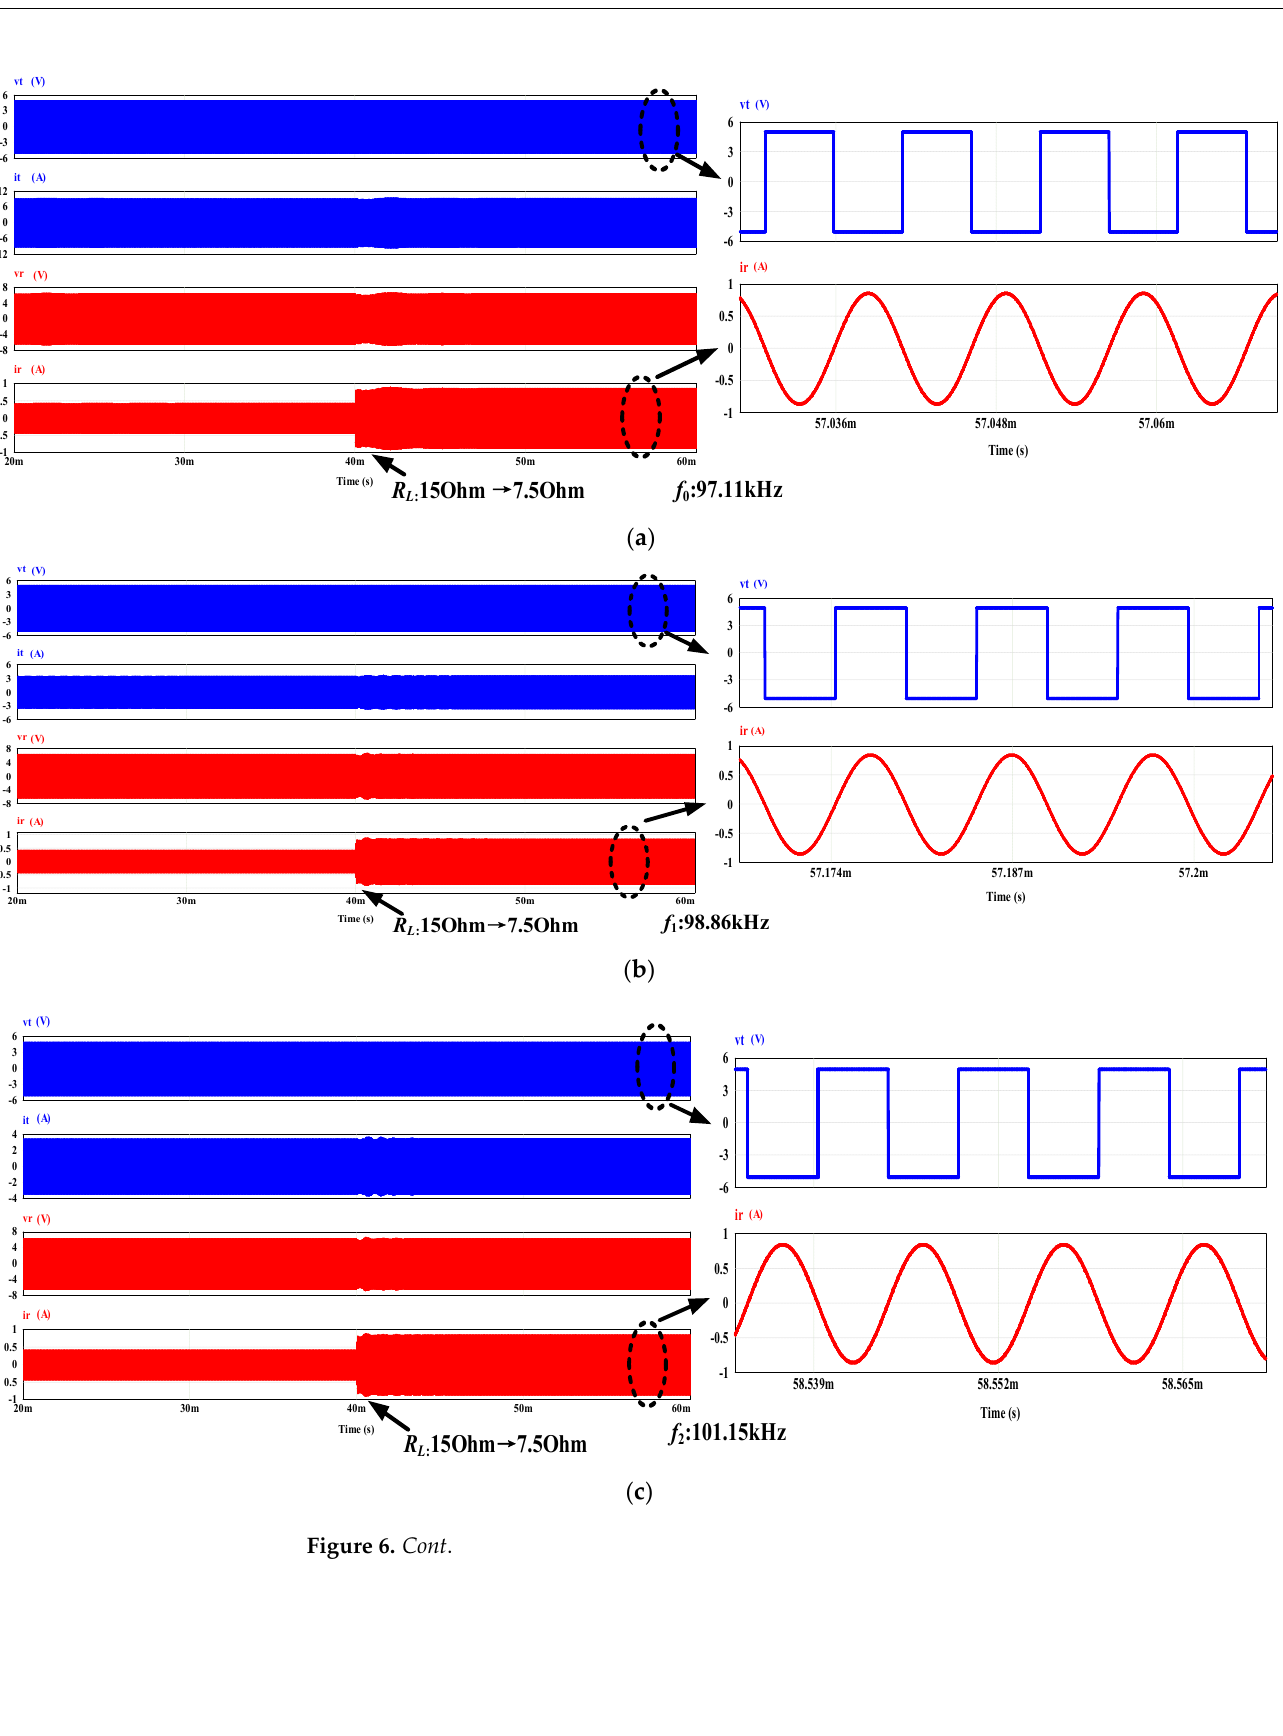
( d ) Figure 6. The waveforms of v t , i t , v r , and i r at the four load-independent CV output frequencies ( a ) f 0 , ( b ) f 1 , ( c ) f 2 , and ( d ) f 3 . It can be seen from Figure 6 that the output voltage can maintain constant versus load shift under the above four load-independent frequencies. In contrast, the fluctuation of the output current is significant. The input voltage is in-phase with the output current in f 1 and f 3 , as shown in Figure 6b,d, respectively, while the input voltage is reverse-phase